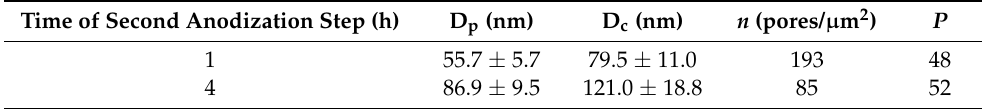
Table 1. Morphological characteristics (D p , D c , n , and P ) of AAO samples.